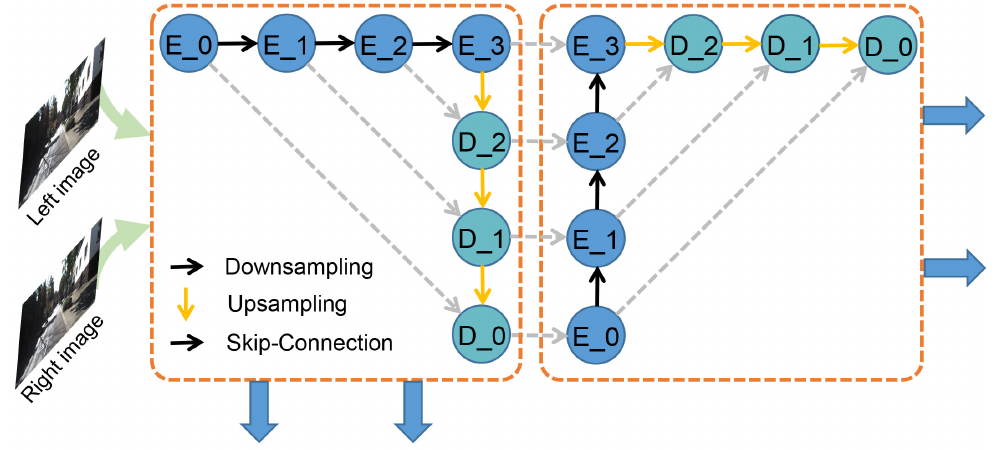
Figure 3. The details of feature extraction. Encoder (E_0, ..., E_3), decoder (D_0, D_1, D_2) and Unet are connected by skip-connections. The first ouput feature is used for the correlation layer and 2D network, while the second is used for concatenation and 3D hourglass